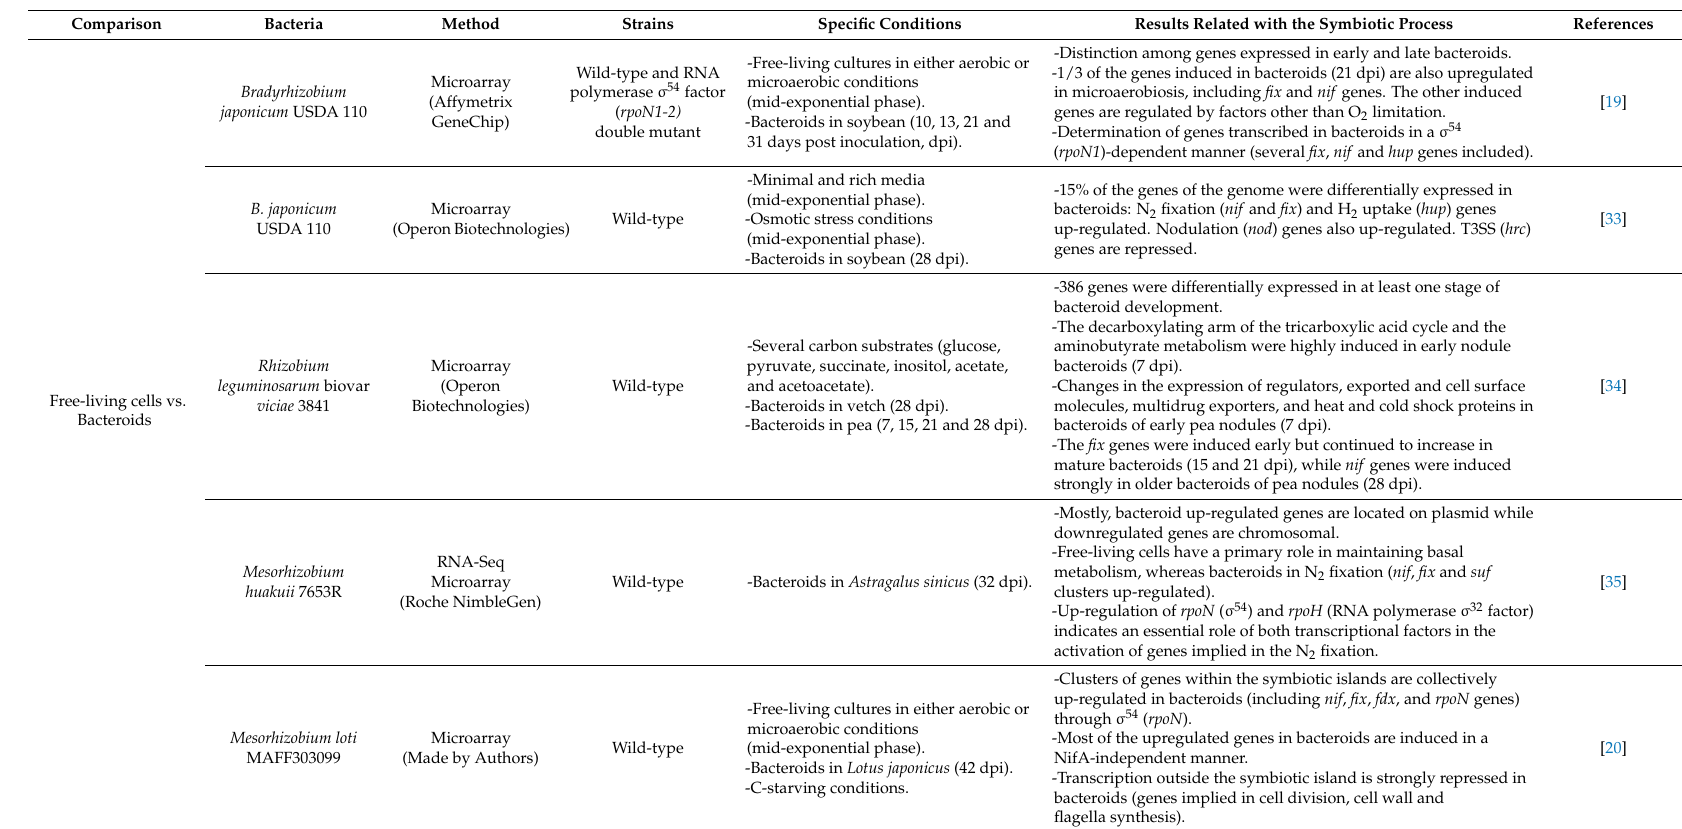
Table 1. Summary of the main results obtained in rhizobial transcriptomic studies related with the symbiotic